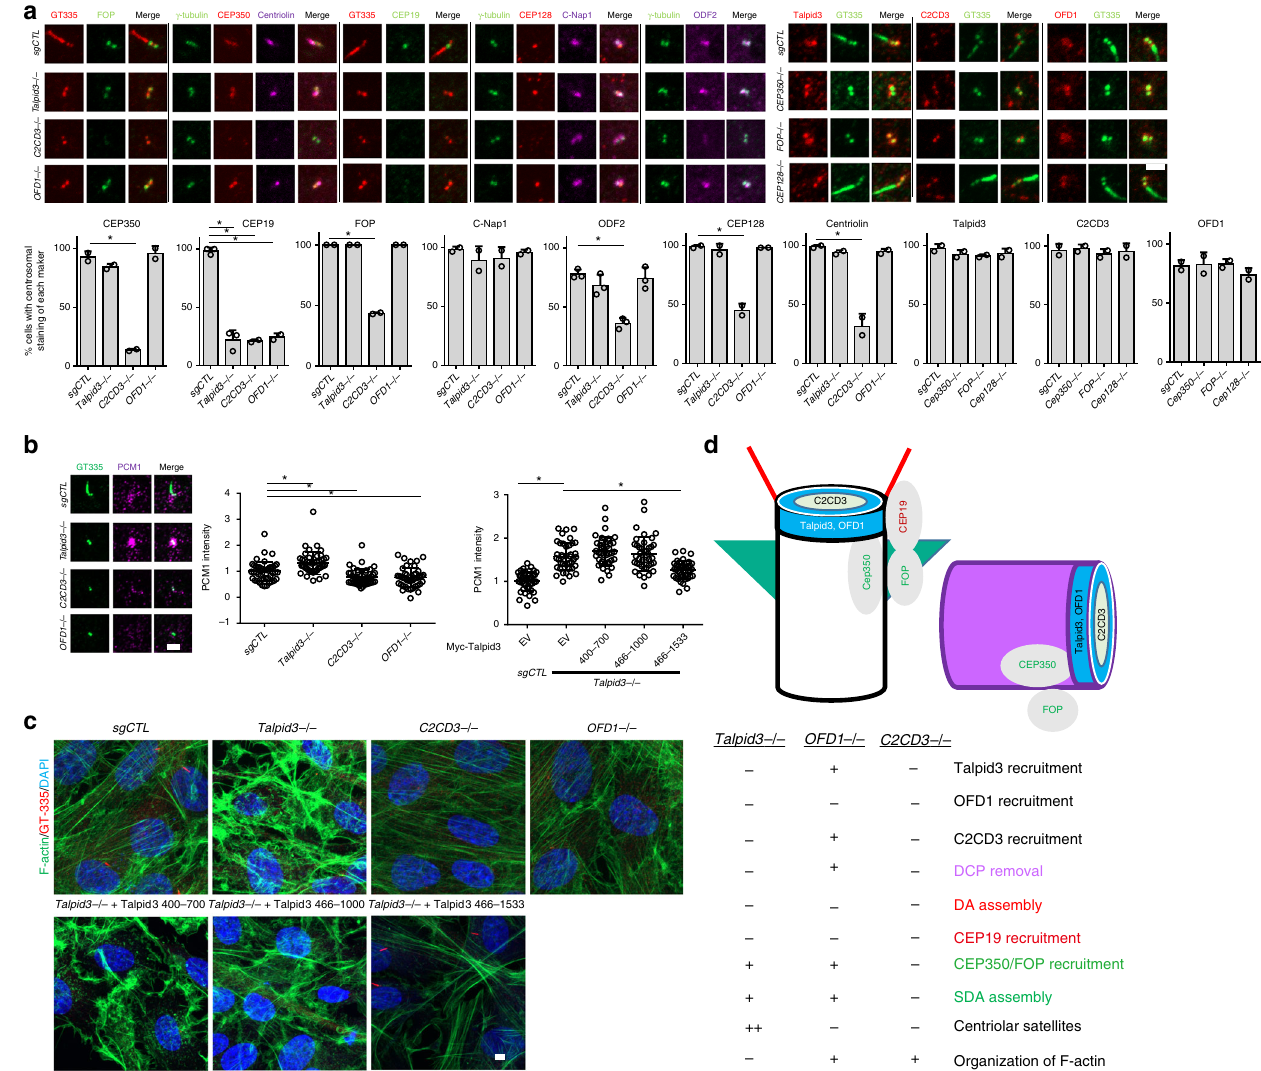
Fig. 7 Unique functions for Talpid3, C2CD3, and OFD1 in assembling distal-end structures. a Localization of CEP350/FOP/CEP19 module, SDA proteins, and b , c the organization of cytoplasmic actin and centriolar satellites (CS) was examined in control, C2CD3 − / − , OFD1 − / − , and Talpid3 − / − cells. Localization of Talpid3, C2CD3, and OFD1 was examined in control, CEP350 − / − , FOP − / − , and CEP128 − / − cells. Cells were serum-starved for 24 h and then visualized with indicated antibodies. Cumulative data from two or three independent experiments are shown in a , as indicated by data dots. For each group, a minimum of 100 cells/experiment was averaged. Data from one experiment are shown in b , with 40 cells per group in the left panel and 45 cells per group in the right panel. Experiments were repeated independently two times with similar results. d Schematic of the unique functions for Talpid3, C2CD3, and OFD1 in assembling distal-end structures, CS and actin network ( − , defective; + , normal; ++ , enhanced). All data are presented as mean ± SD. * p < 0.05 (unpaired t -test). Scale bars = 2 μ (Supplementary Fig. 1c). Conversely, ablation of CEP350 or FOP does not affect the localization of Talpid3, C2CD3, and OFD1. These data suggest that the Talpid3 – OFD1 – C2CD3 network, together with FOP and CEP350, play a prominent role in recruitment of CEP19. C2CD3 can be placed higher in a regulatory hierarchy by controlling recruitment of OFD1, FOP, and CEP350, and Talpid3 could regulate CEP19 localization through OFD1 (see Discussion).